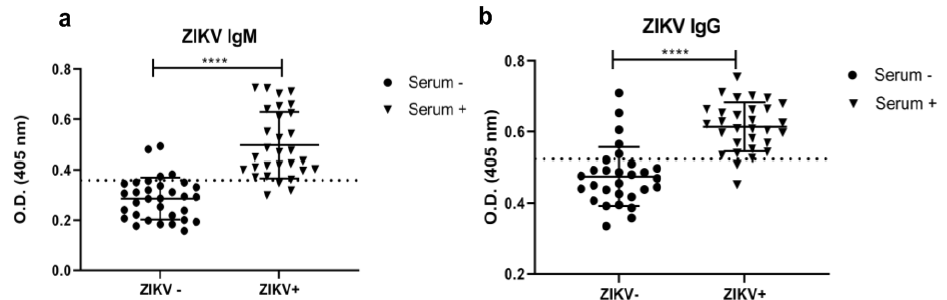
Figure 4. Anti-ZIKV indirect ELISA. ( a ) Anti-IgM and ( b ) Anti-IgG. ZIKV+ represents positive serum and ZIKV– represents negative serum. The dashed line shows the cut-off for each antibody isotype from the ROC curve, 0.3593 for IgM and 0.5234 for IgG. Each dot in the graph represents a different sample. **** refers to the p < 0.0001. Table 2. Sensitivity and specificity of the indirect ELISA. Unpaired t -test for significance. Receiver operating characteristic (ROC) curves were analyzed to estimate the diagnostic sensitivity and spec- ificity. % Sensitivity % Specificity Cut-Off p -Value